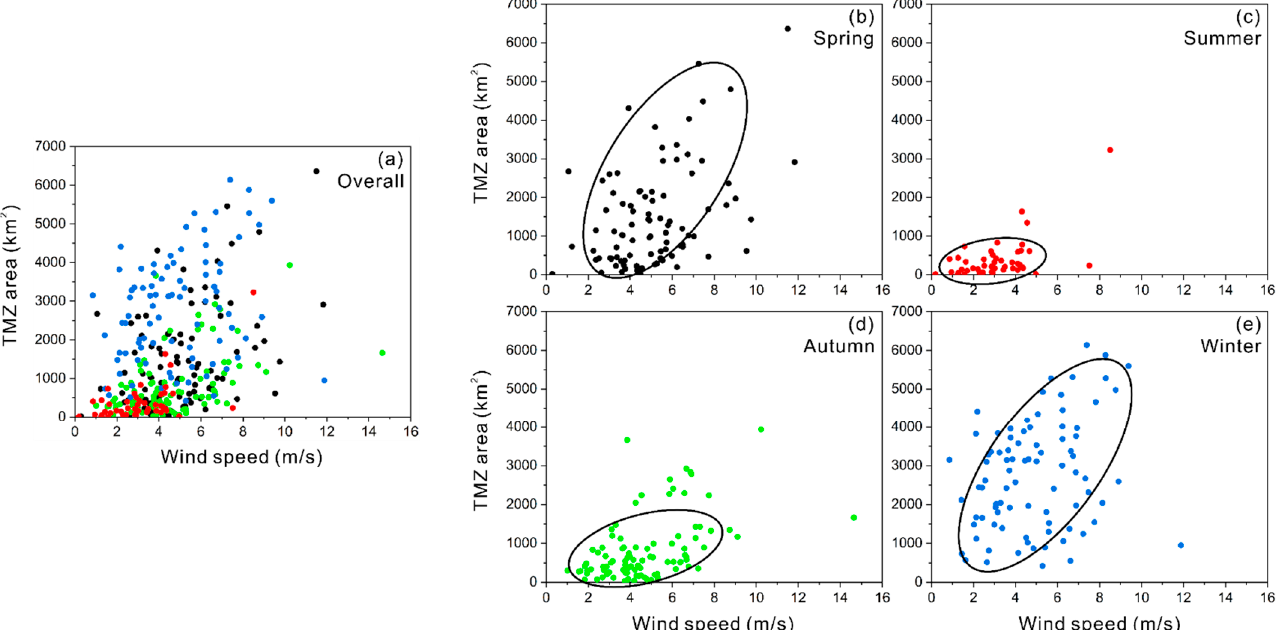
Figure 11. Relationship between the TMZ area and the synchronous wind speed from 1984 to 2021. ( a ) is the scatterplot of all derived TMZ area results and its corresponding wind speed. The points in ( b – e ) are in spring, summer, autumn and winter from 1984 to 2021, respectively. The ellipse in ( b – e ) circles most of the points and excludes the outliers. The slope of the major axis of ellipses roughly represents the level of the response sensitivity of TMZ area to wind speeds.